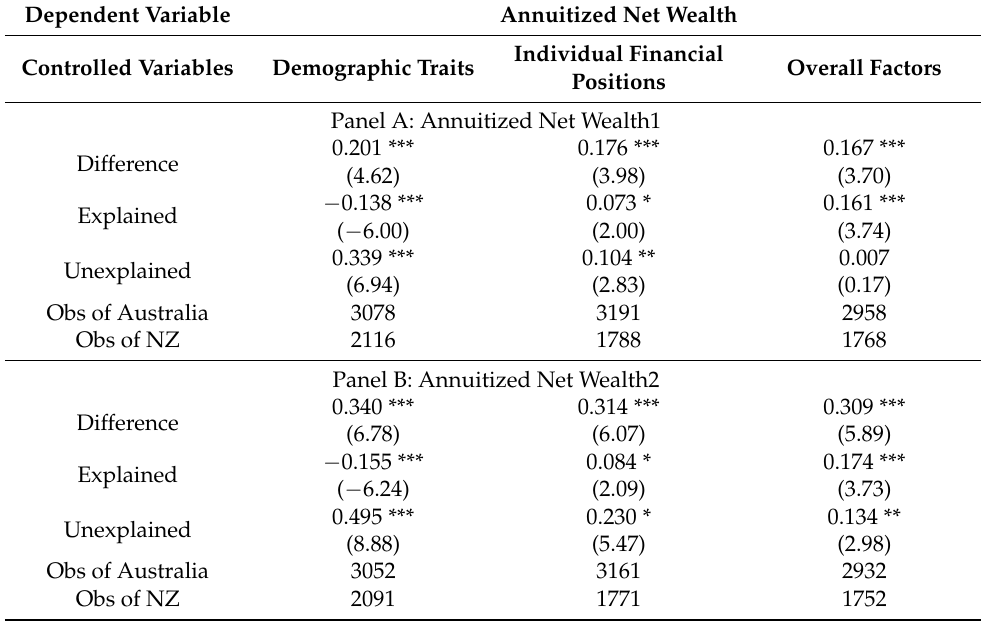
Table 12. Other distributional decomposition methods (top 10%).